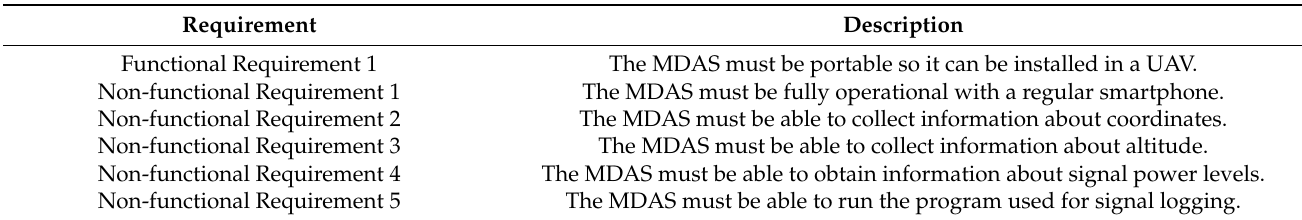
Table 5. MDAS requirements.